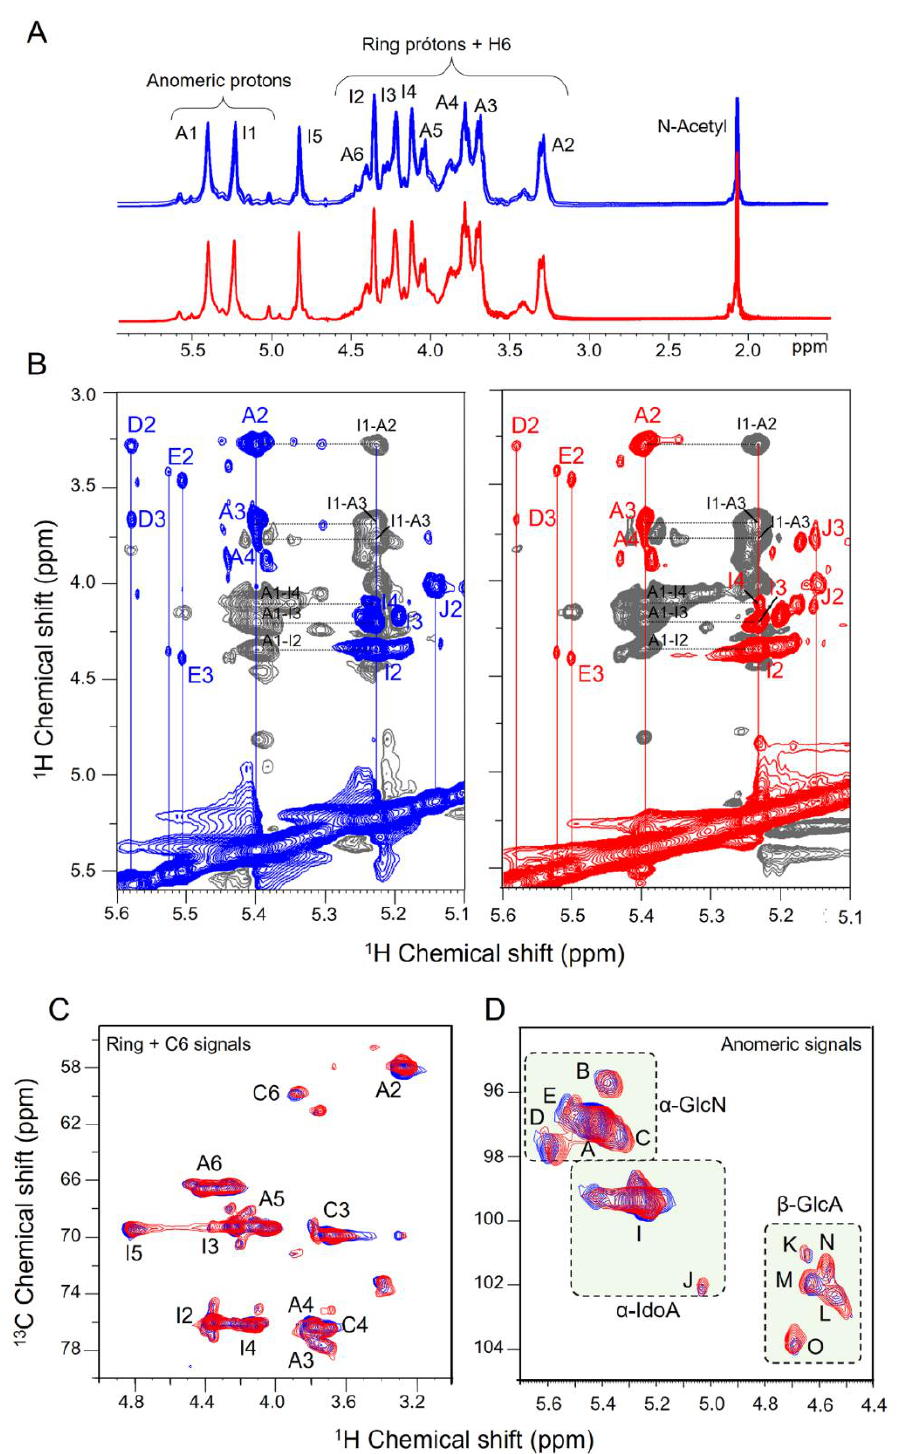
Figure 4. NMR analyses of the pharmaceutical heparins. Panel ( A ): overlapped 1D 1 H NMR spectra of three batches of heparins from each manufacturer 1 ( blue ) and manufacturer 2 ( red ). Panel ( B ): Representative 2D 1 H- 1 H phase-sensitive TOCSY spectra of one batch each from the two manufacturers. Panels ( C , D ): Overlapped 2D 1 H- 13 C spectra of one batch each from the two manufacturers. Note that the signals in purple result from the merging of the individual signals in red and blue from each heparin, indicating their similarities. Anomeric signals are assigned and quantified as indicated in Table 3.